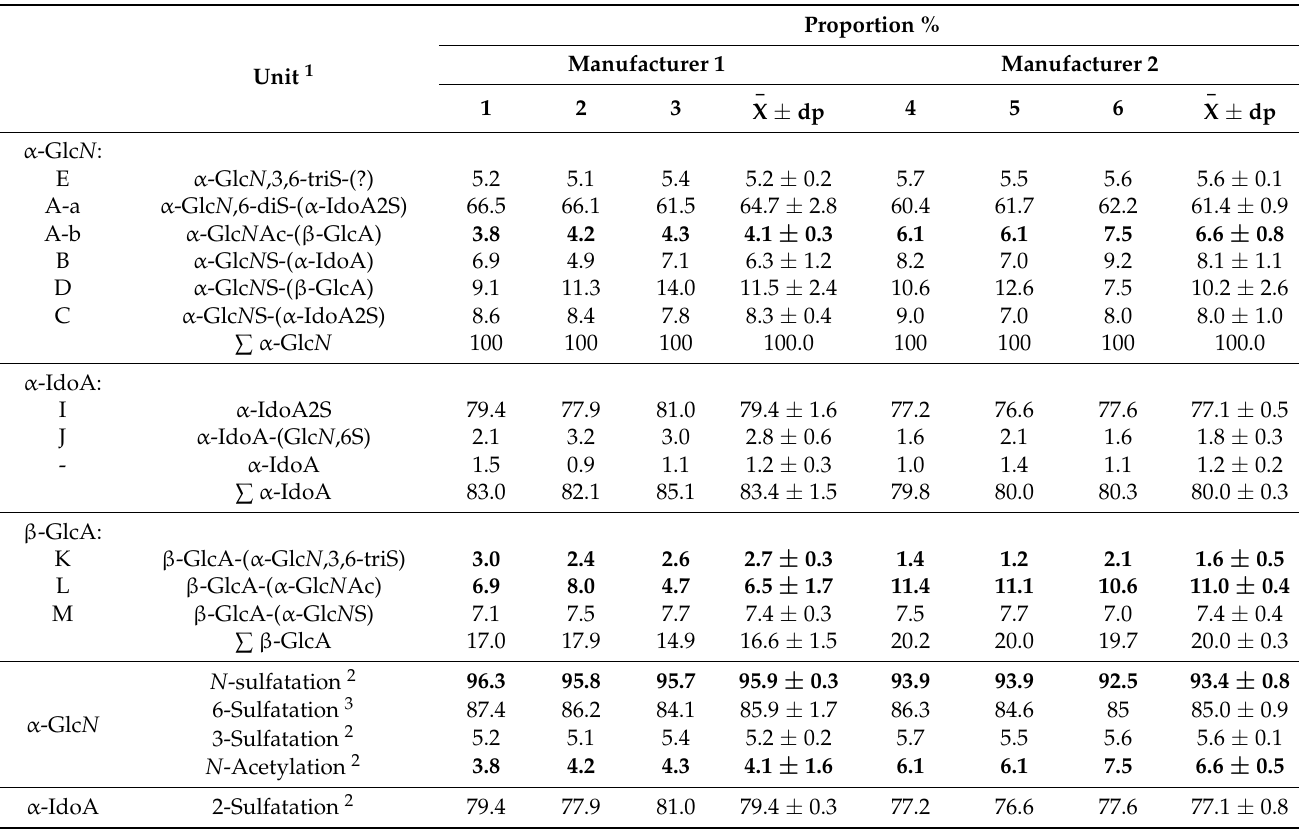
Table 3. Quantification of the monosaccharide units (%) of pharmaceutical heparin from two manu- facturers calculated based 1 H- 13 C HSQC